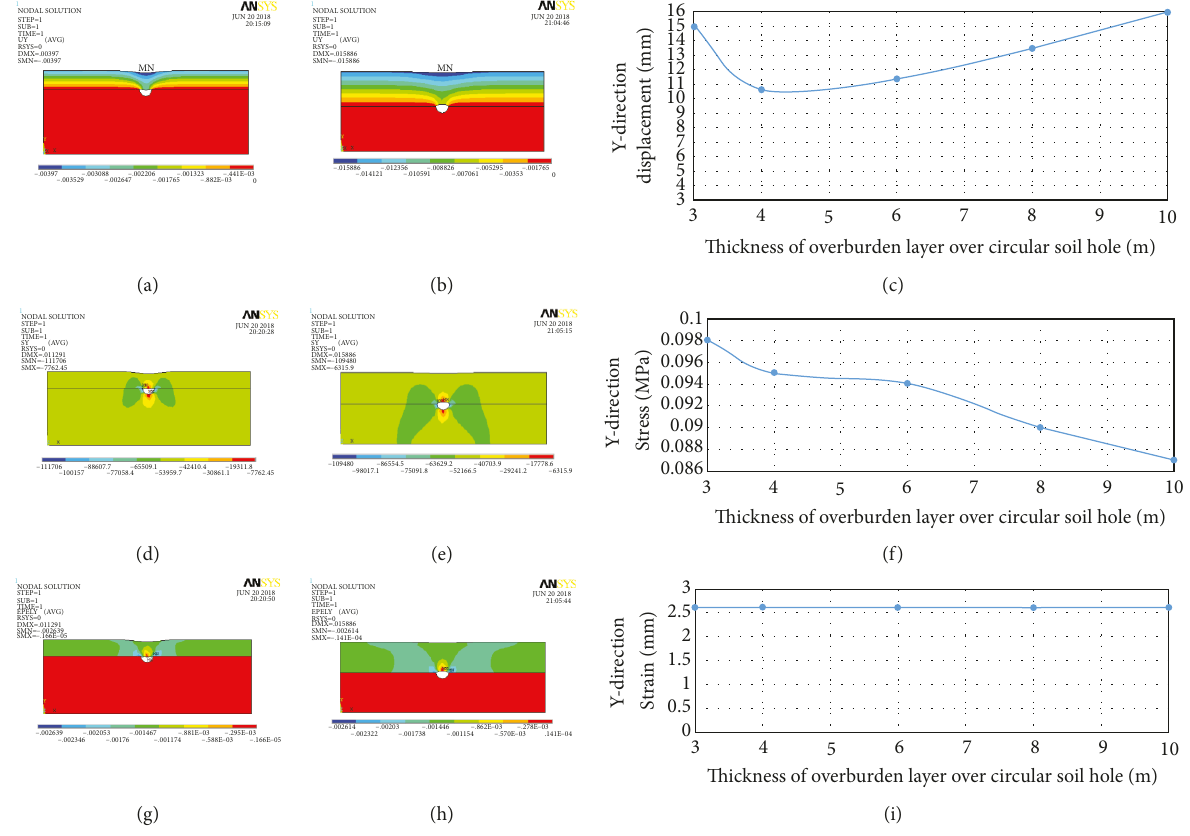
Figure 8: q � 50.89kPa scenario. Results of displacement cloud map: (a) H � 6m and (b) H � 10m; (c) displacement curve; stress cloud map: (d) H � 6m and (e) H � 10m; (f) stress curve; strain cloud map: (g) H � 6m and (h) H � 10m; (i) strain